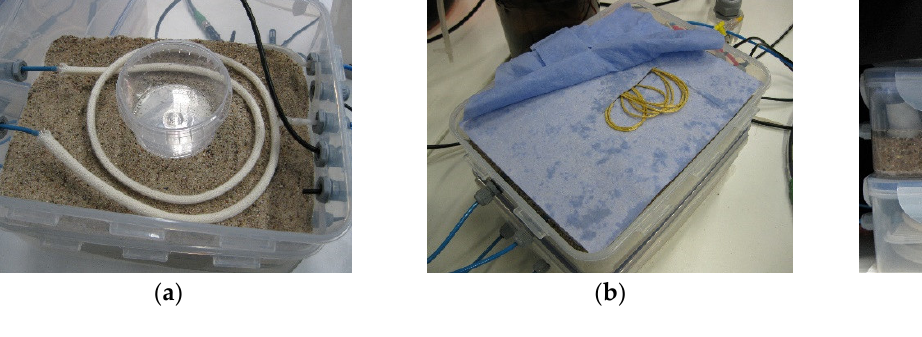
Figure 2. Test container used for Experiment 3. ( a ) A membrane tube integrated into a cotton hose was placed onto a sand layer. The plastic vessel in the center served as a water storage. ( b ) After covering the membrane tube with sand and installing the EE060 sensor above it, water was added to the plastic vessel and connected by a capillary thread (yellow), with a cloth placed on a grid to allow the water to evaporate into the closed test container for Phase 1. ( c ) The light areas (marked with a red arrow) within the watered sand pack in Phase 2 indicate residual amounts of trapped air.